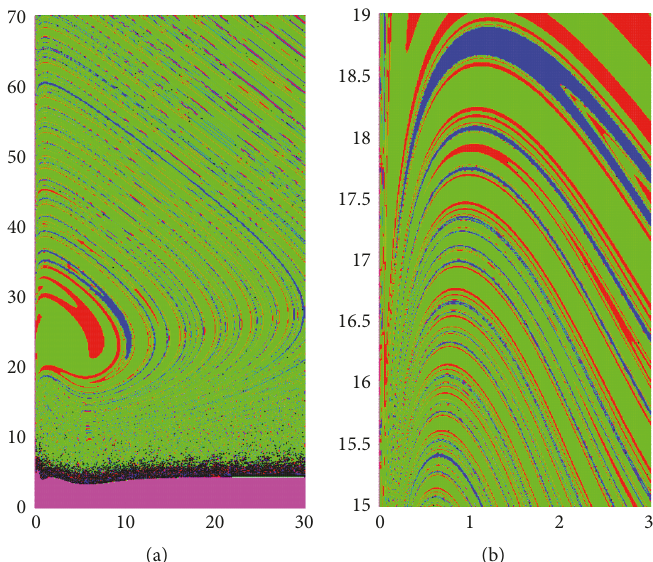
Figure 7: Basin of several attractions shown in Figure 6. The magenta, red, blue, and green points are attracted to the attractor shown in Figure 6 from top to bottom, respectively. The black points represent the other attractors not shown in Figure 6.